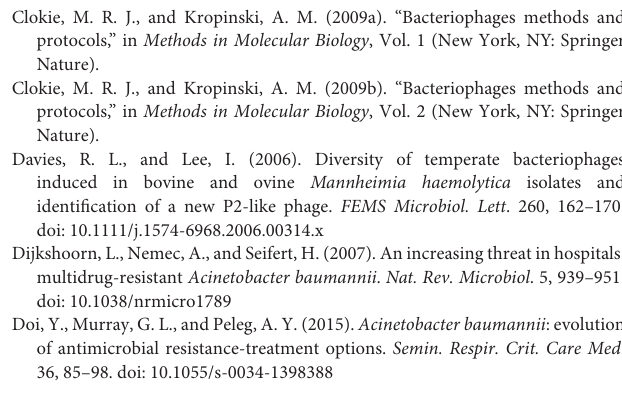
Supplementary Figure 1 | Histamine levels in sera from mice treated with phages using three different routes, intraperitoneal (i.p), intranasal (i.n), or